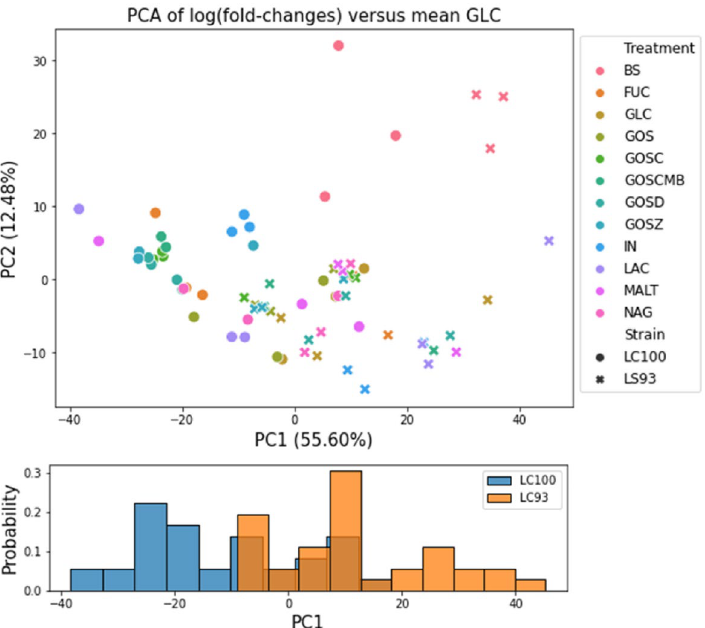
Figure 5. Principal component analysis (PCA) of feature abundance changes across media additives compared to media controls. Each marker in the figure represents one of three replicates in the corresponding treatment (shown in different colors). Numbers in parenthesis indicate the variance explained by each of the principal components. The histogram on the bottom represents the distribution of samples from each of the two strains along the first principal component. GLC, glucose. The data are representative of 3 independent experiments.